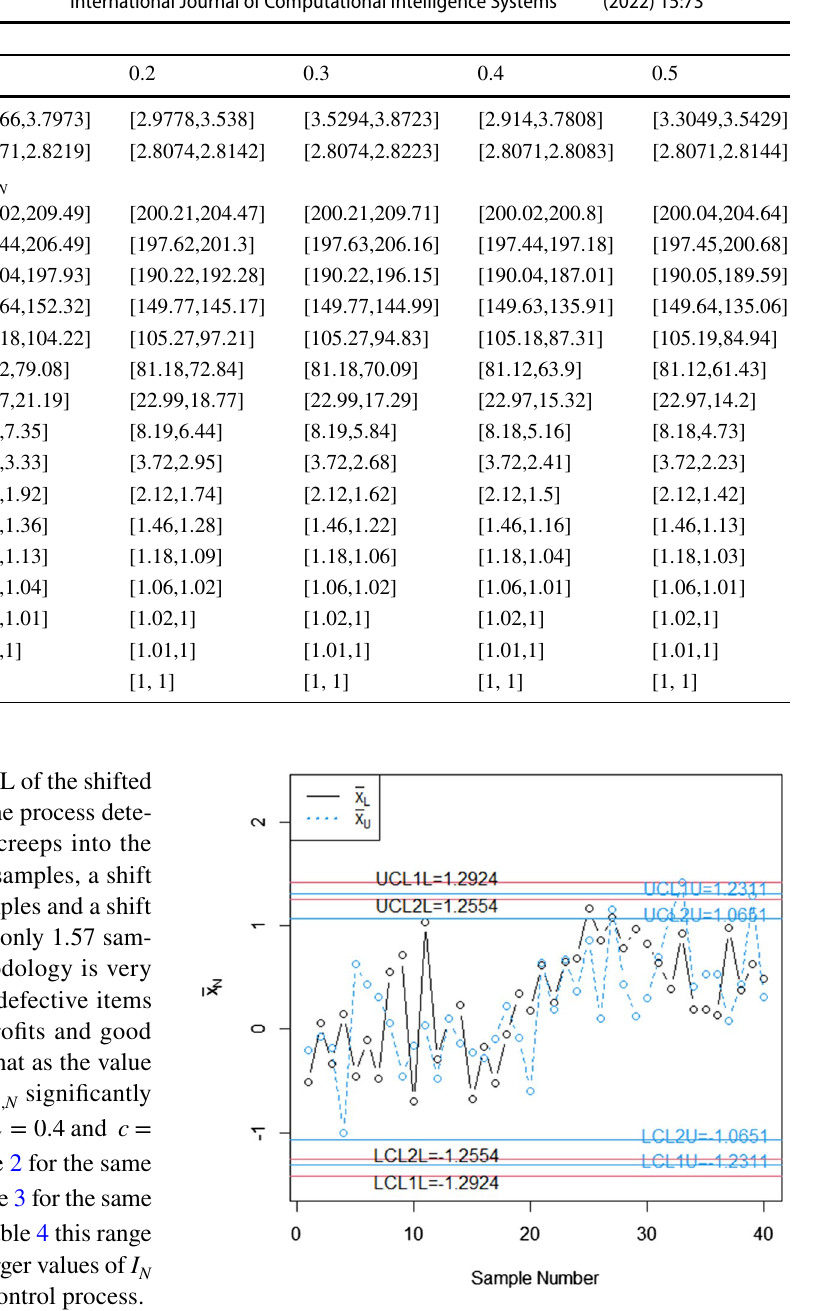
Fig. 1 The proposed control chart for simulated